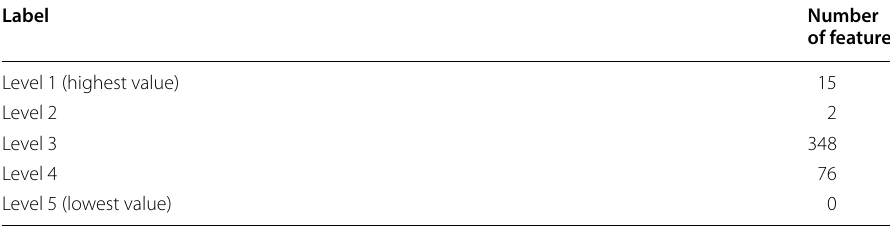
Table 4 Feature classification summary for robot failure